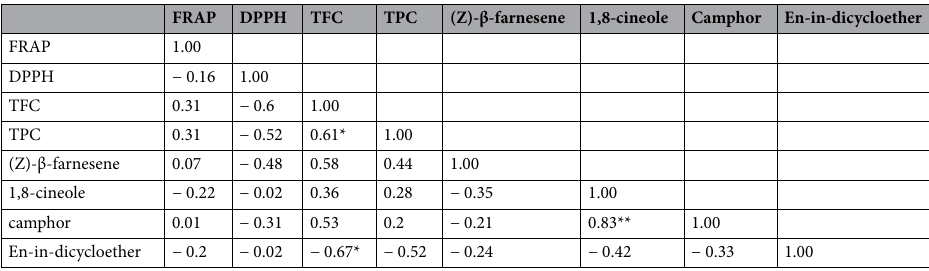
Table 3. Correlation coefficients among antioxidants and major essential oil components of Artemisia accessions. *Correlation is significant at the 0.05 level. **Correlation is significant at the 0.01